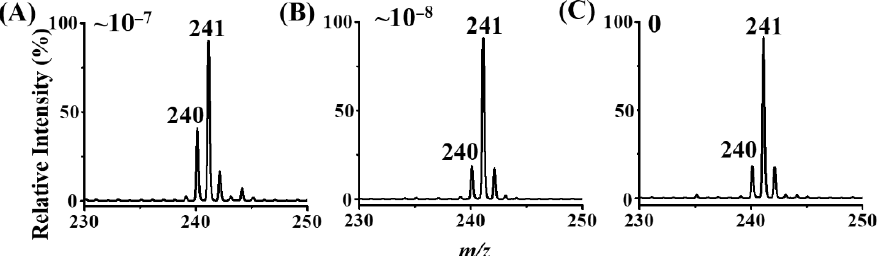
Figure 5. C-API mass spectra of the orange juice (3 mL) containing E. coli O157:H7 with the concentrations of OD 600 of ( A ) ~10 − 7 , ( B ) ~10 − 8 , and ( C ) 0, prepared in the PBS buffer (10 mM, pH 7.5) obtained after enriched by MALCY-probe, followed by releasing the bacteria trapped on the probe to ammonium acetate buffer (pH 4.5, 8 µL) and reaction with H 2 O 2 (100 mM, 1 µL) and TMB (1 mg mL −1 , 1 µL) for 15 min.